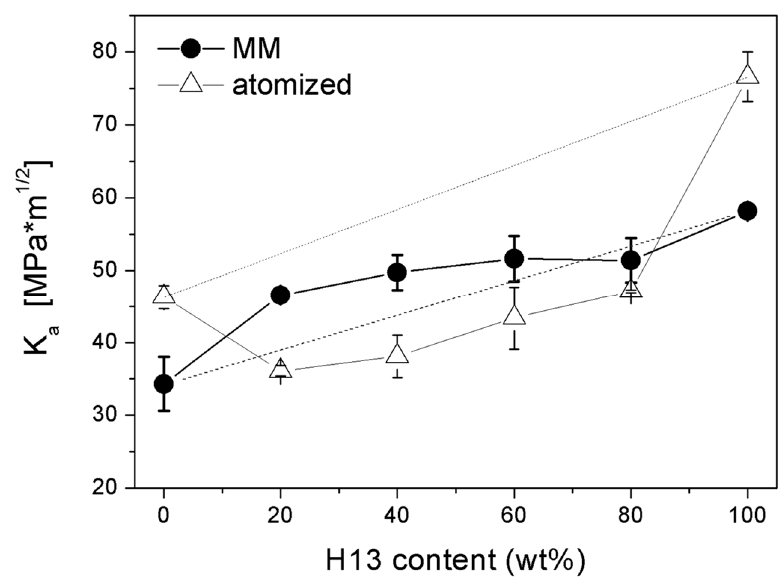
Figure 12. Apparent fracture toughness of tool steels from atomized and mechanically milled powders as a function of the AISI H13 content.